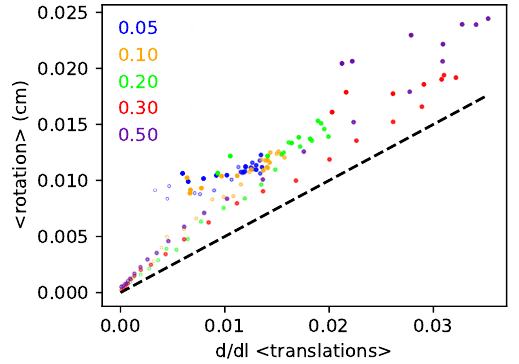
Figure 5. Correlation between the spatial derivative of the grain displacements and the rotations for di ff erent values of friction. The transparency of symbols corresponds to the distance to the far-right corner as given in Figures 3 and 4. The dashed line is the theoretical correlation of a sphere rolling between two moving plates, which has a slope of 1 / 2. The legend corresponds to the value of friction, µ S